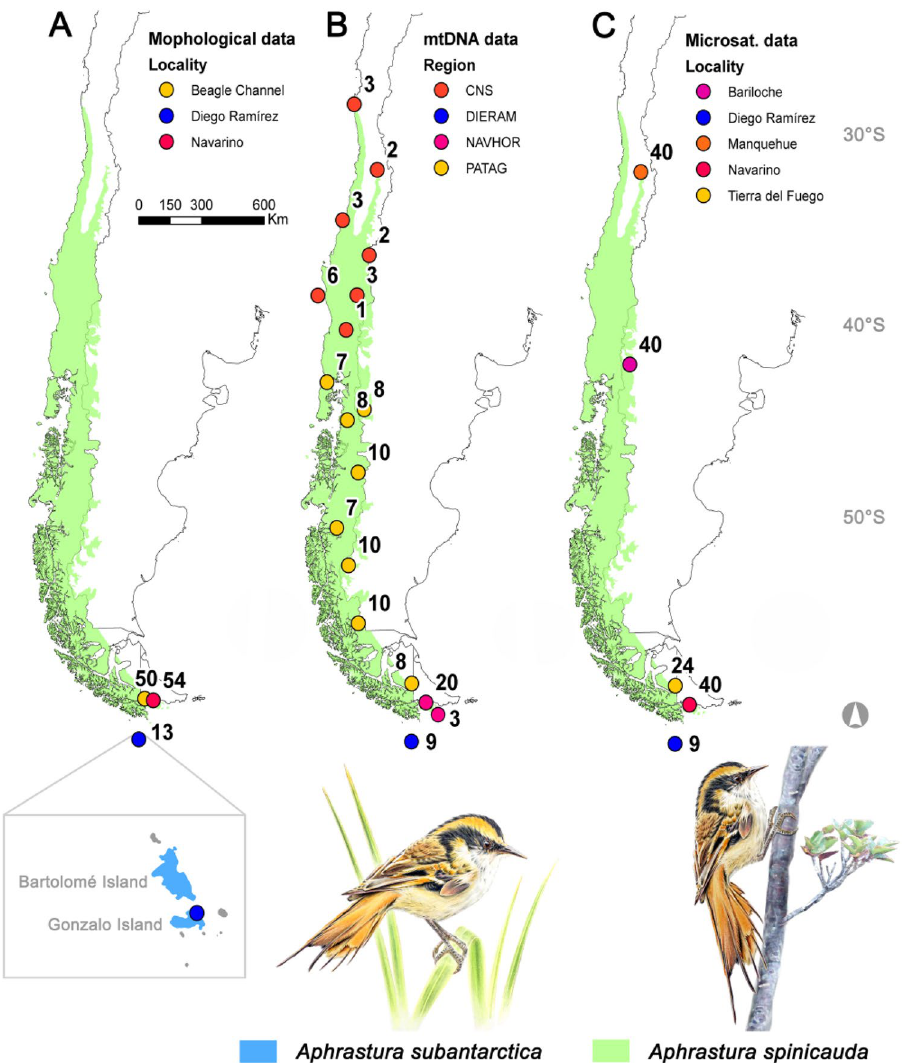
Figure 1. Study areas for the morphological and genetic characterization of Aphrastura spinicauda and A. subantarctica . The distribution range of the nominal species is shown in light green, and the new taxonomic group from the Diego Ramírez Archipelago in light blue. ( A ) Sampling sites for morphology. ( B ) Sampling sites for mtDNA. ( C ) Sampling sites for microsatellite markers. The numbers correspond to the sample size. The names of the colored sites follow the methods description, and Tables 1 and 2. Bird illustrations by Mauricio Alvarez